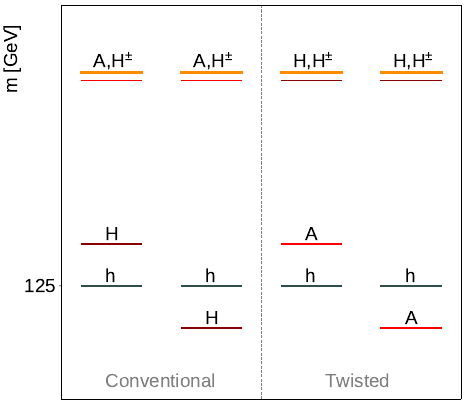
Figure 1 . Possible 2HDM mass hierarchies: conventional, where A is degenerate in mass with the charged scalars; and twisted [9], where H is degenerate in mass with the charged scalars. In both scenarios, the lighter of the A and H bosons can be either heavier or lighter than the observed Higgs boson h(125).